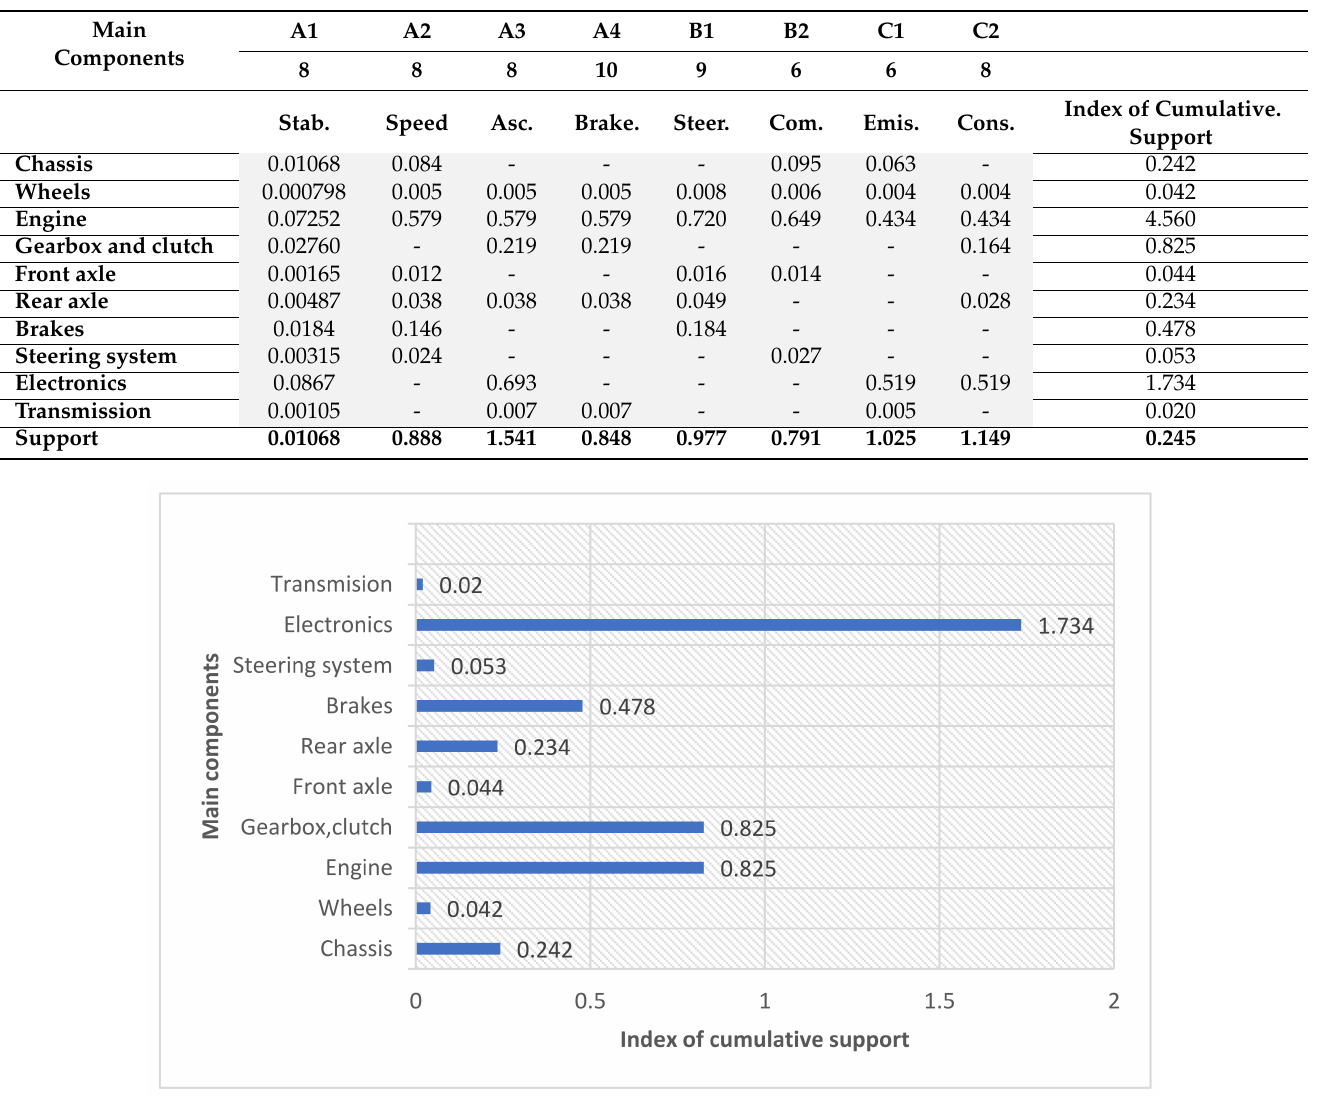
Table 6. Maintenance support index matrix.